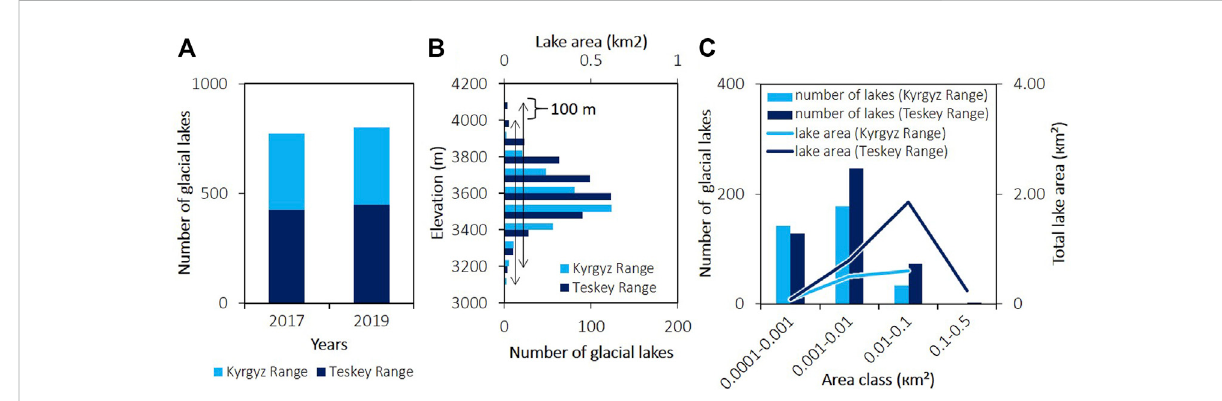
FIGURE 2 A static comparison of glacial lakes between the Kyrgyz and Teskey ranges. The Figure shows the number of glacial lakes between 2017 and 2019 (A) , the distribution of glacial lakes with elevations (B) , and the number and area class of glacial lakes (C)